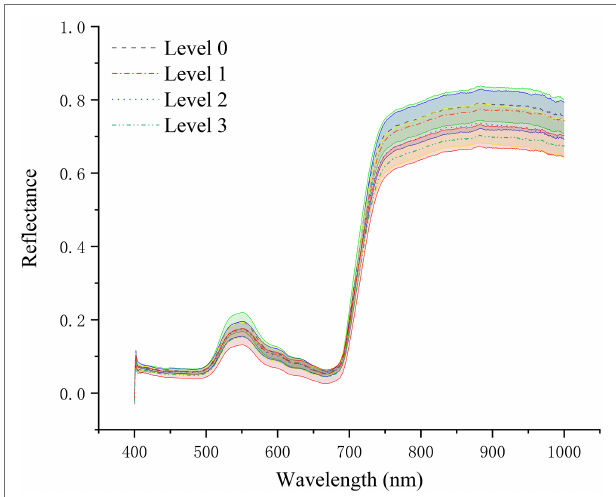
FIGURE 4 | Average leaf reflectance curves and corresponding standard deviation values of healthy rice plants and rice plants at different disease stages.